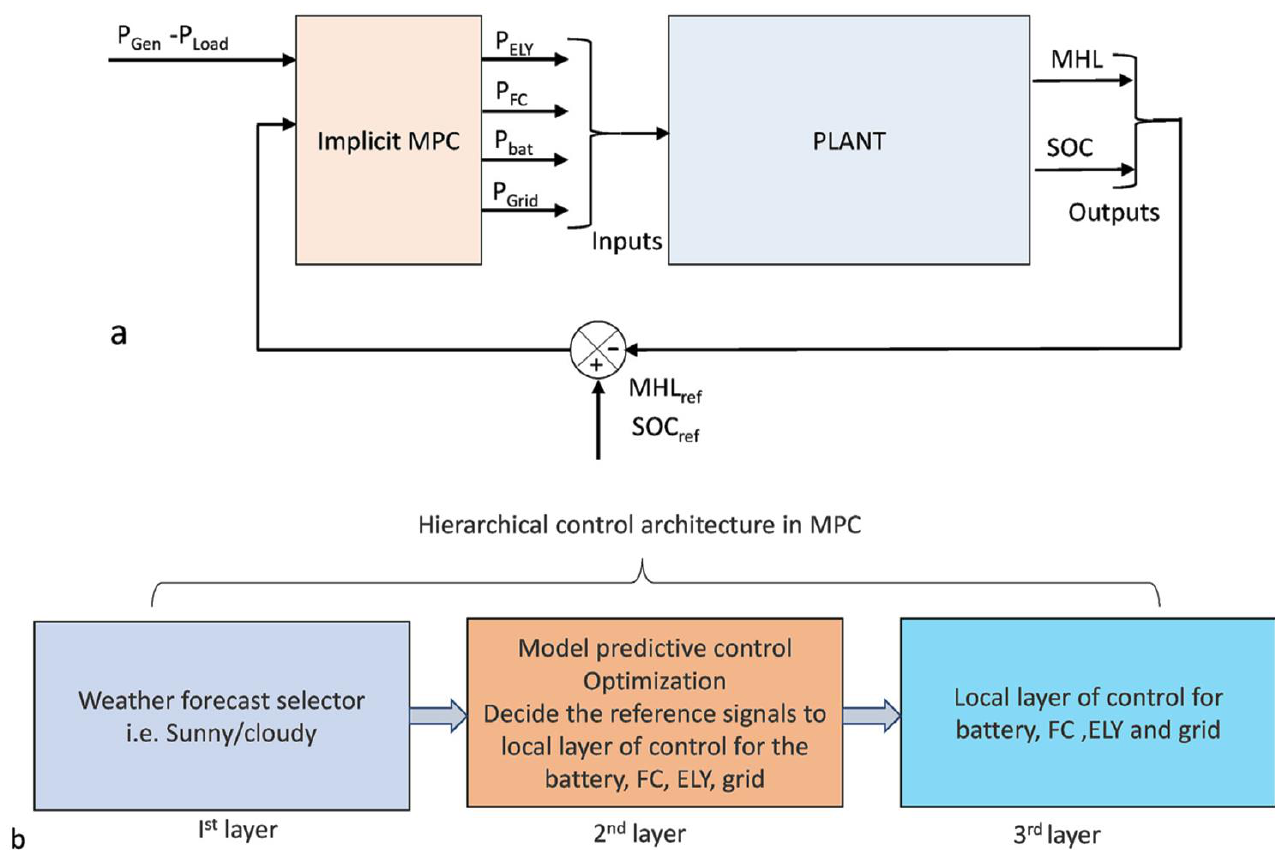
Figure 9. ( a ) Block diagram of a model predictive controller. ( b ) Hierarchical structure of the control system of a microgrid configuration. Reprinted with permission from Ref. [39]. 2021, Elsevier. Table 2. Control strategies for hybrid PV-RHFC microgrid